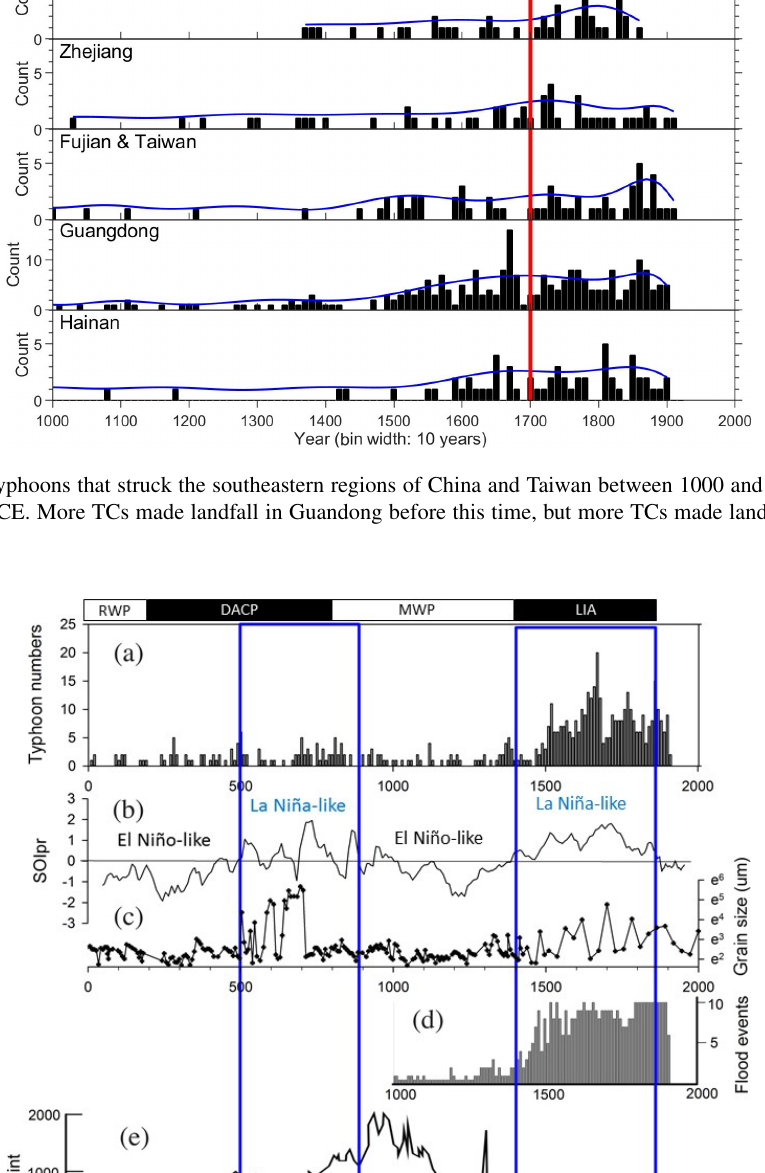
Clim. Past, 15, 279–289, 2019